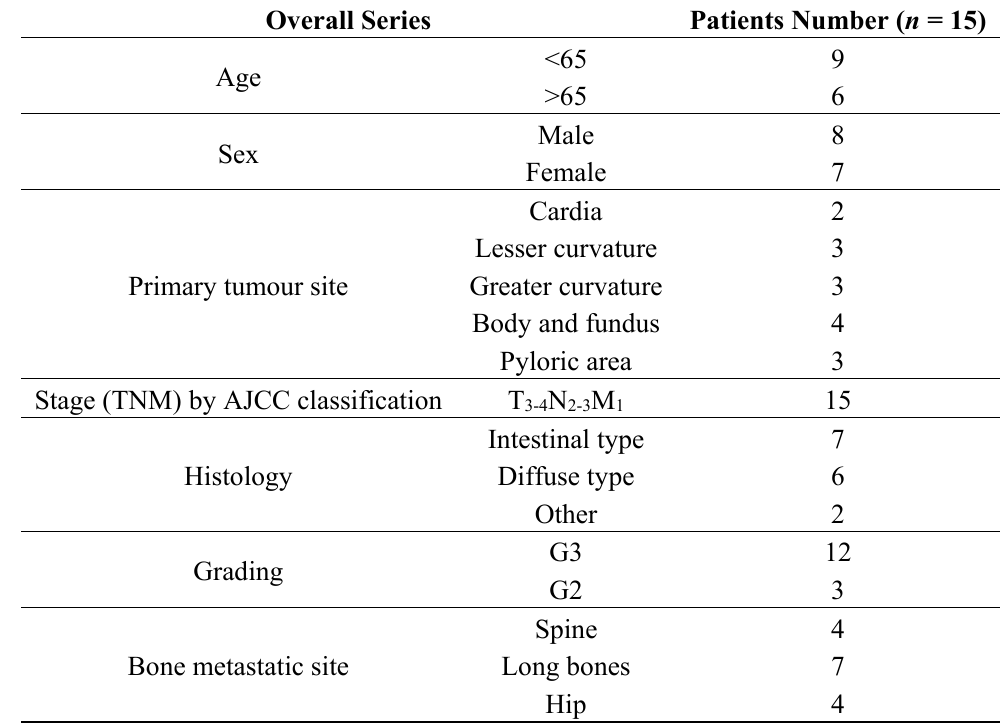
Table 2. Clinico-pathological features of 15 BMGCP